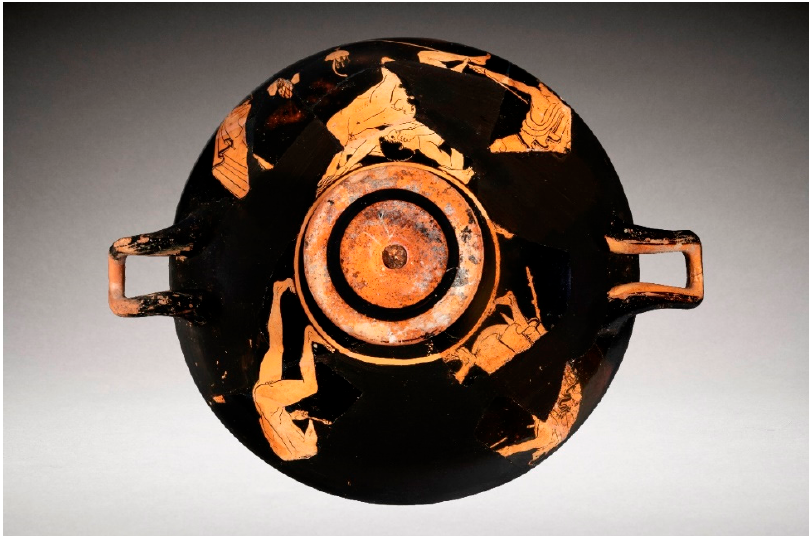
Figure 2. Exterior of Figure 1. Baltimore, Johns Hopkins Archaeological Museum B11. Photo courtesy the Johns Hopkins Archaeological Museum. Used by permission. 490–80 BCE.